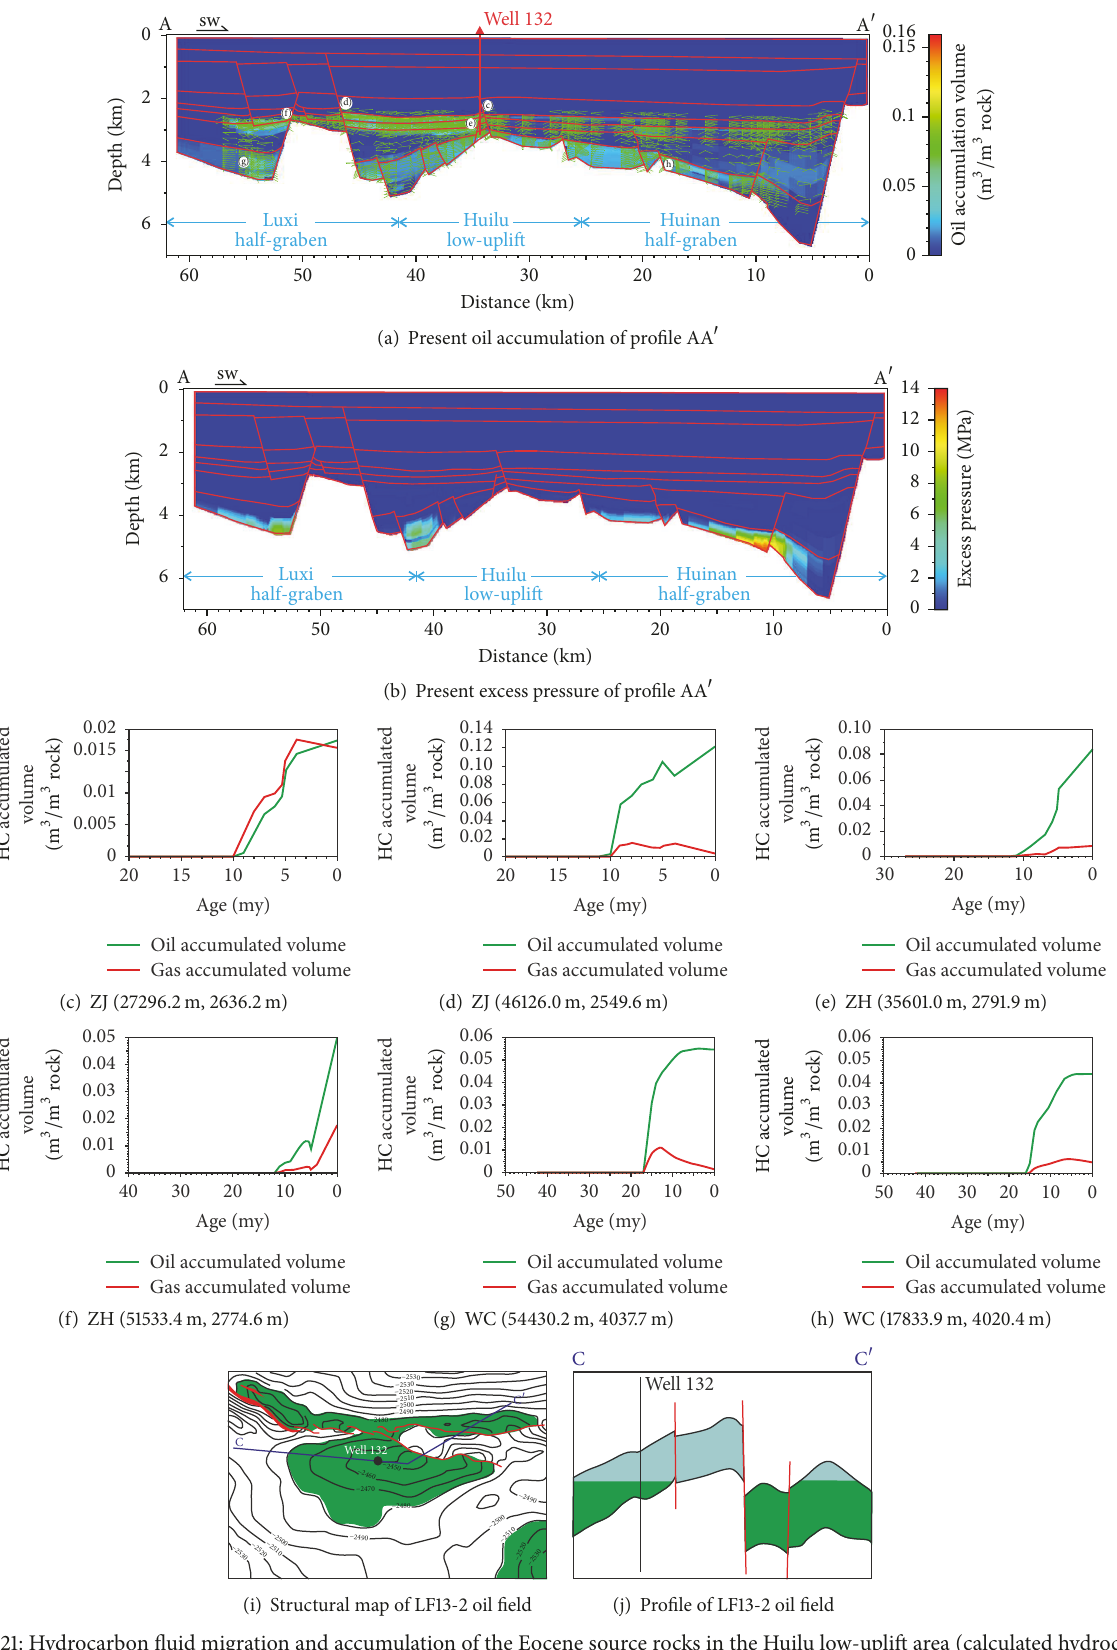
Figure 21: Hydrocarbon fluid migration and accumulation of the Eocene source rocks in the Huilu low-uplift area (calculated hydrocarbon volume is expressed in reservoir condition. The locations of well 132 and profile AA 󸀠 are shown in Figure